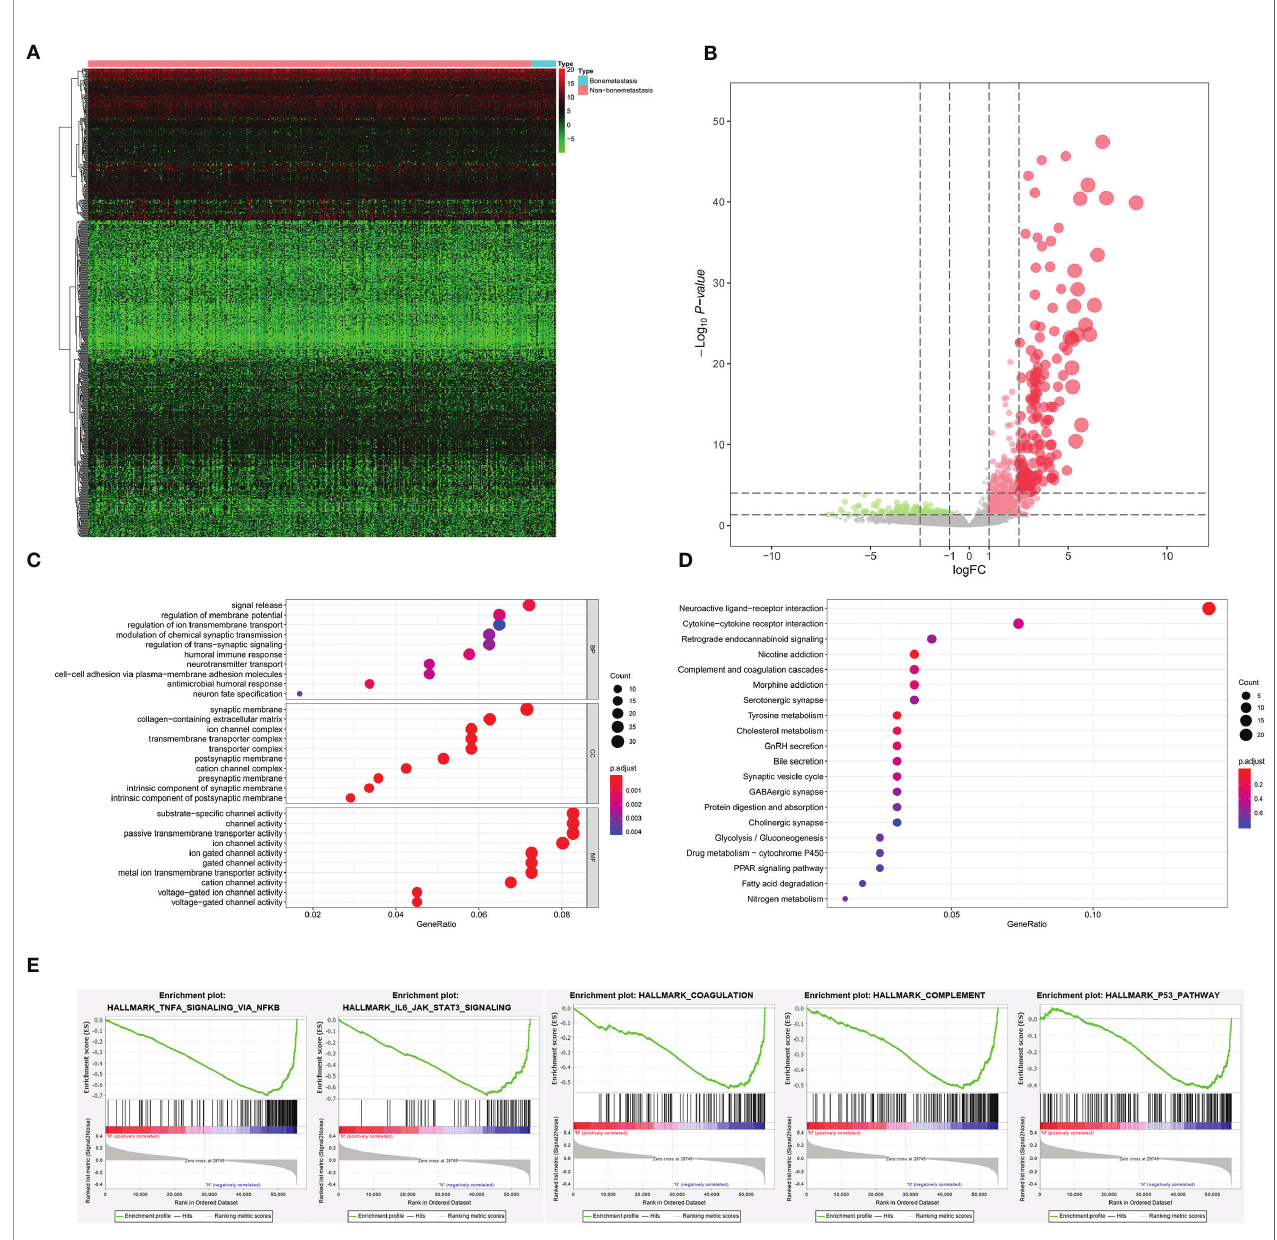
FIGURE 5 | The results of differential expression genes analysis and functional enrichment analysis between BLCAs with and without bone metastasis: The heatmap (A) and volcano plot (B) of the differential expressed genes. The GO (C) , KEGG (D) , and (E) top fi ve GSEA enriched terms for the differential expressed